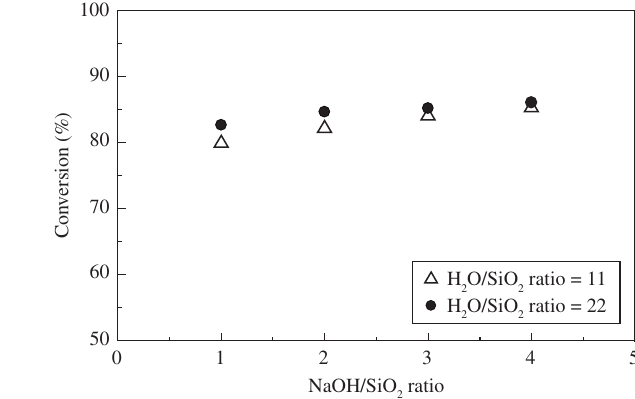
Figure 1. Flow diagram for production of soluble sodium silicate. Figure 3. Silica conversion as function of NaOH/SiO